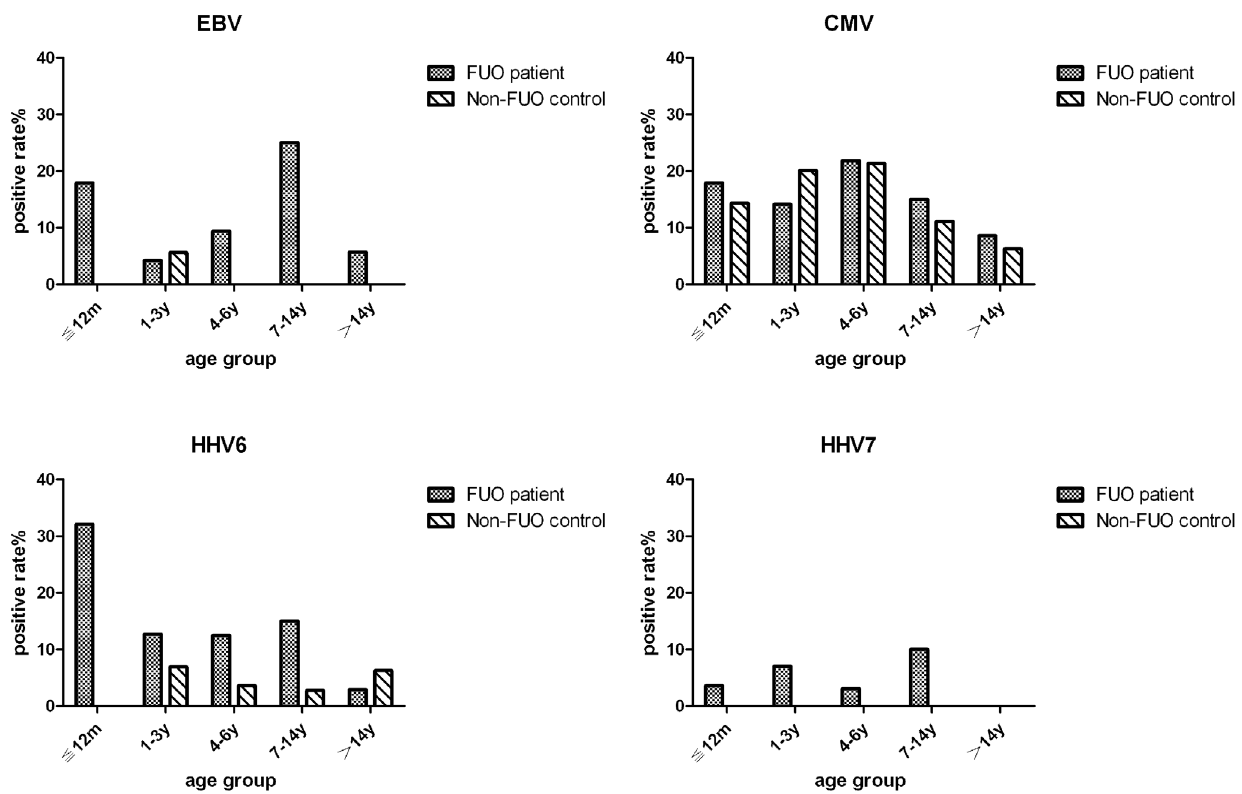
Figure 1. Distribution of HHVs among different age groups in this study.